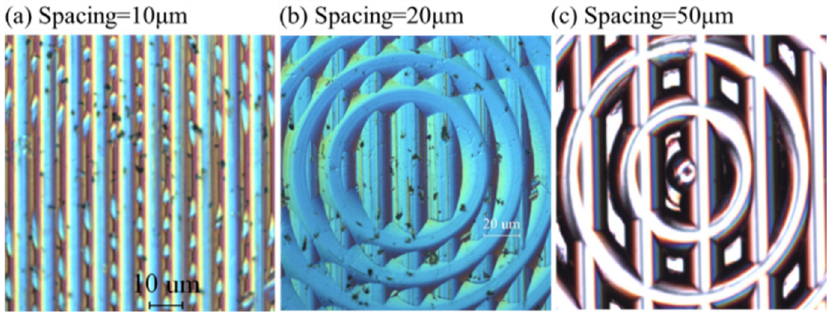
Figure 20. Experimental results of machining a polar microstructure with different groove spacing.